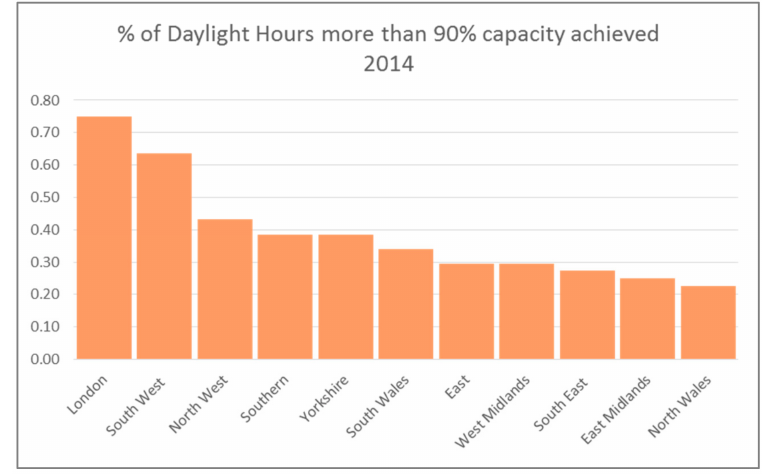
Figure 18. Percentage of daylight hour more than 90% capacity achieved by UK solar farm fleet 2014.